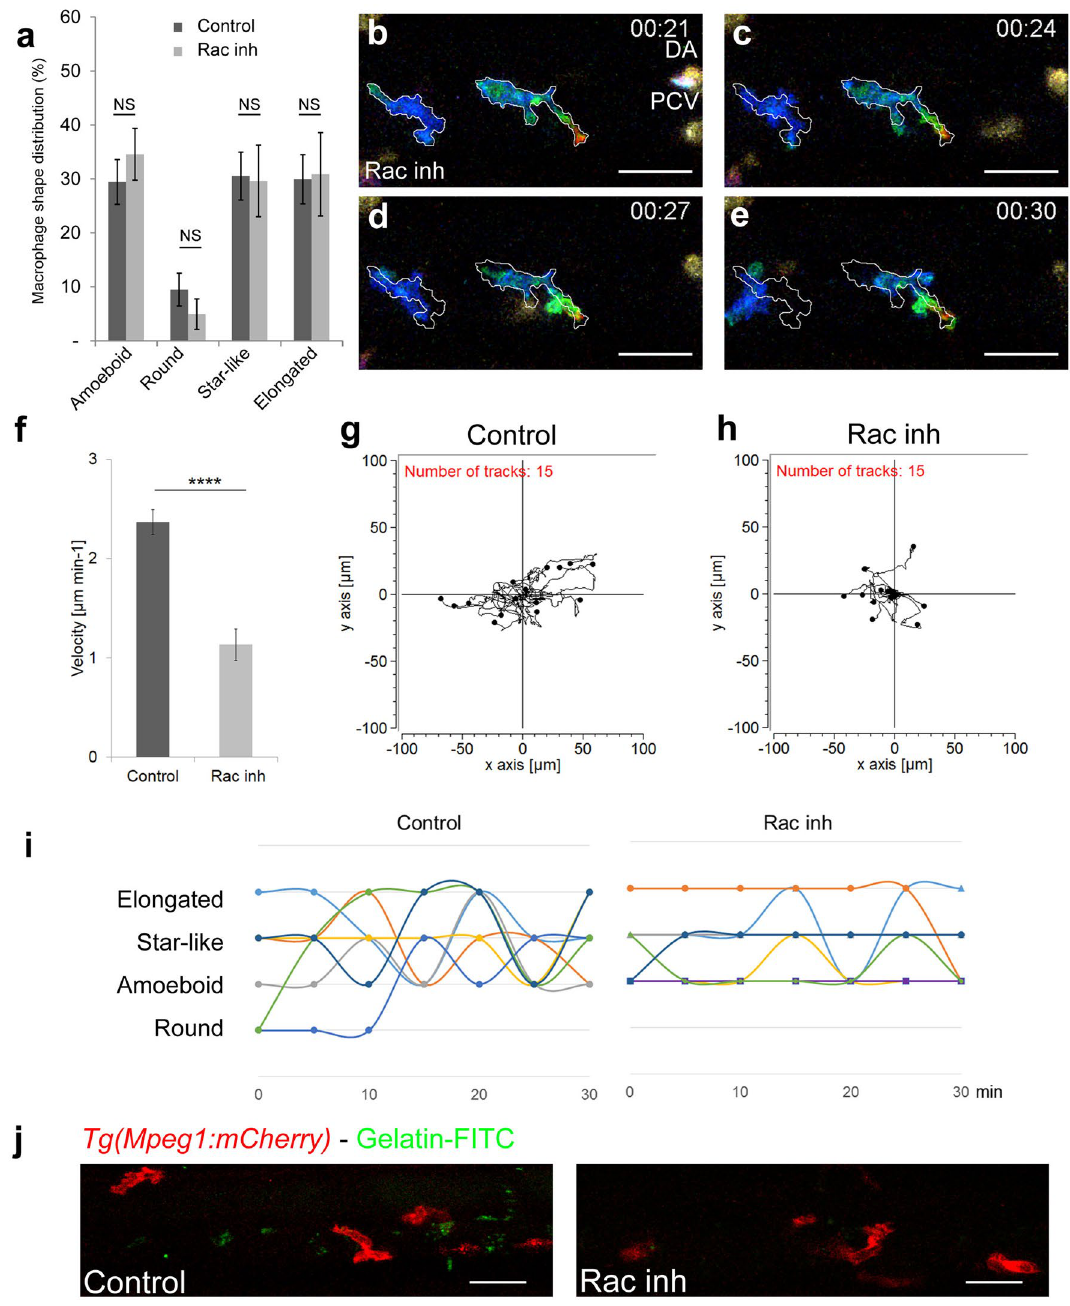
Figure 3. Rac inhibition leads to a loss of macrophage plasticity and motility. ( a ) Graph comparing macrophage shape distribution in the AGM of NSC23766 Rac-inhibited embryos (Rac Inh) to DMSO treated embryos (control) shows no significant change of distribution. N = 10 embryos for control and 15 for Rac inh. Data are represented as the mean of the percentage of each shape type in the total macrophage population in the AGM ± s.e.m. NS = not significant. ( b – e ) Selected cropped images from Video 2 showing the shape and migration of macrophages over time of Rac inhibited embryo. Time code in hours and minutes. White outlines on panel ( c – e ) indicate the shape and position of macrophages from panel ( b ) (21st minute). ( f ) Graph showing the velocity of macrophages in control and Rac-inhibited embryos. Data are represented as a mean ± s.e.m., n = 15 macrophages from 4 different embryos, ****p < 0.0001. ( g , h ) Tracking plot diagram representing the migration path and distance of macrophages in the AGM in control and Rac-inhibited embryos measured every minute for 60 min. Scale in µm, n = 15 macrophages from 4 different embryos. ( i ) Graph shows the shape evolution of individual macrophages during a 30 min course with 5 min interval measurements, Control to the left, Rac inhibitor to the right. Each line represents a single macrophage (n = 7). Statistically significant differences exist in the number of shapes adopted during a 30 min measurement course (P = 0.003) as well as in the number of changes between two different shapes (P = 0.006). ( j ) In vivo zymography in Tg(Mpeg1:mCherry) embryos at 48 hpf reveals the degradation of inserted gelatin (green dots of cleavage-revealed FITC) in control embryos and a highly reduced degradation after Rac inhibition. See also Video 2. Scale bar 30 µm. See also Supplementary Figure